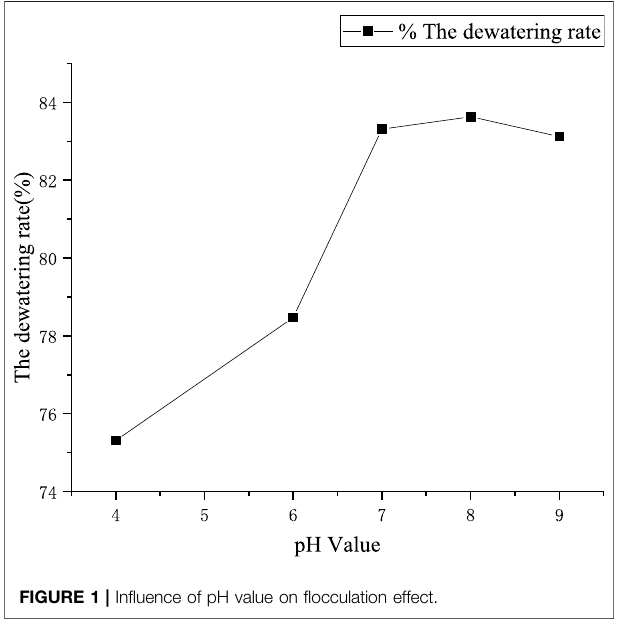
FIGURE 1 | In fl uence of pH value on fl occulation effect.